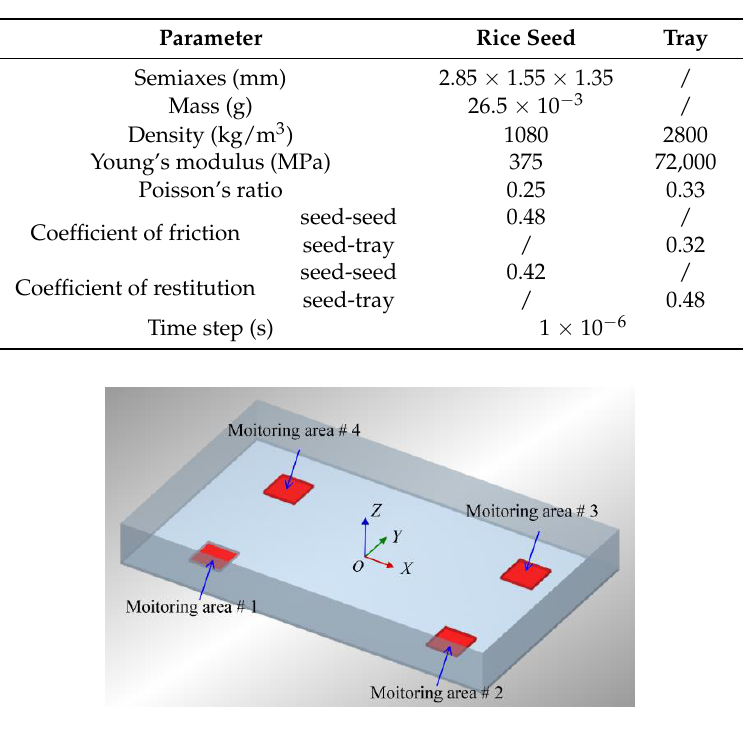
Table 1. Values of material properties used in the discrete element method (DEM).